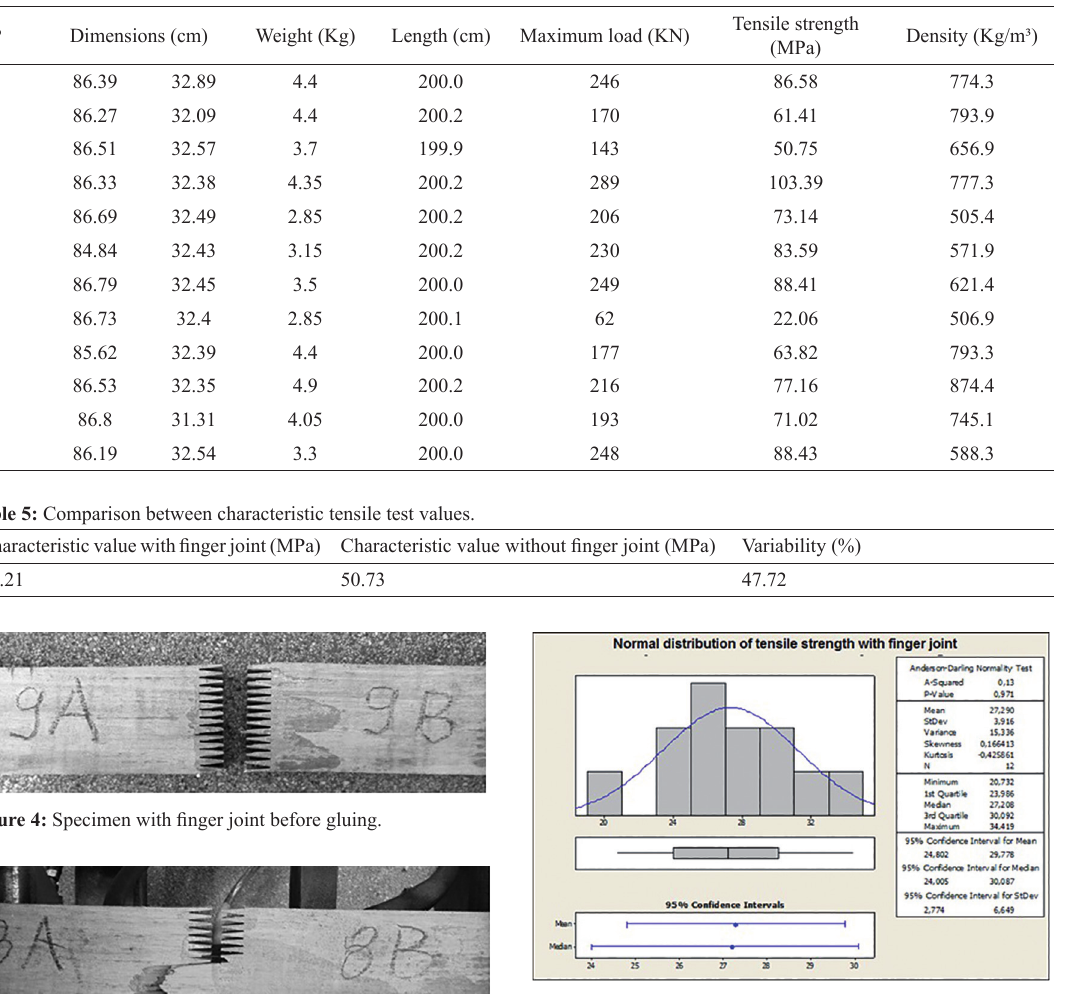
Table 4: Tensile test results for specimens without finger joints.